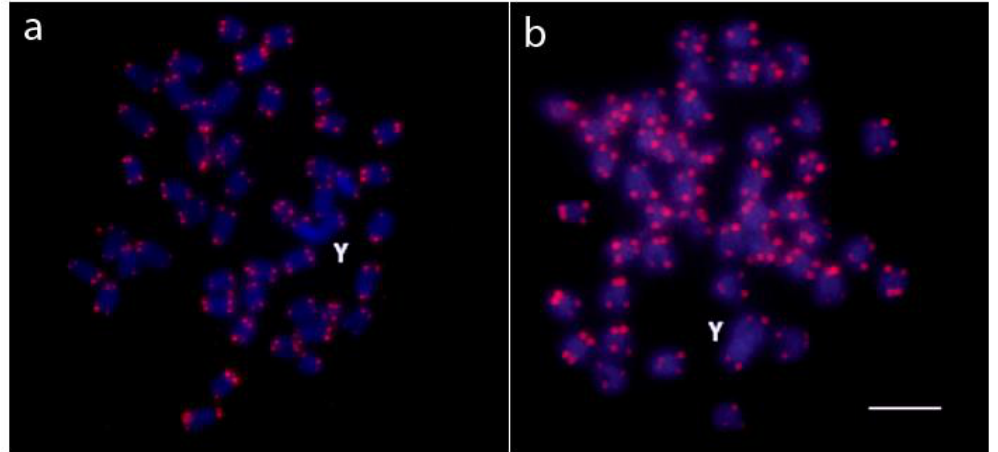
Figure 3. Metaphase plates of O . fasciatus ( a ) and O . punctatus ( b ) showing the location of telomeric (TTAGGG) n repeats. Chromosomes were counterstained with DAPI (blue). Bar = 5 µm.